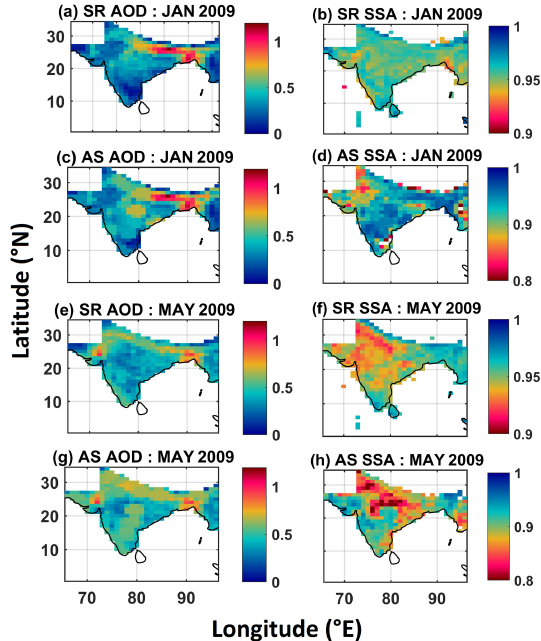
Figure 1. Spatial variation of (a) SR AOD for January 2009, (b) SR SSA for January 2009, (c) AS AOD for January 2009, (d) AS SSA for January 2009, (e) SR AOD for May 2009, (f) SR SSA for May 2009, (g) AS AOD for May 2009 and (h) AS SSA for May